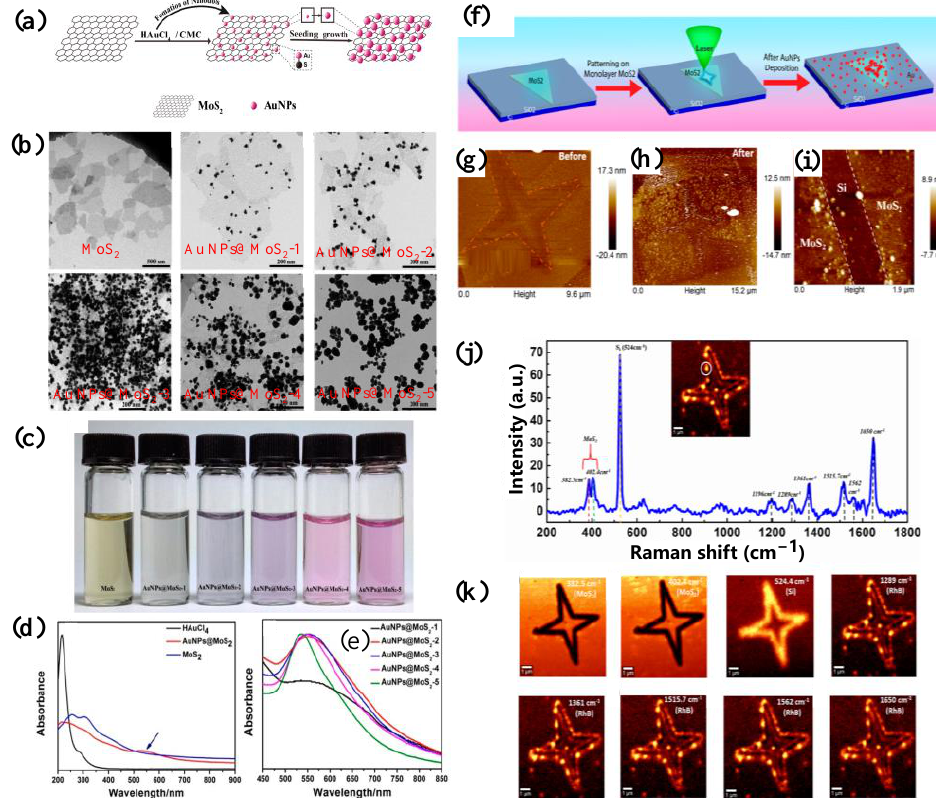
Figure 9. ( a ) Schematic illustration of synthesizing Au NPs@MoS 2 nanocomposite. ( b ) TEM images of MoS 2 and five kinds of Au NPs@MoS 2 nanocomposite with different numbers of Au NPs named from Au NPs@MoS 2 -1 to Au NPs@MoS 2 -5. ( c ) Photo images of MoS 2 nanosheets and different Au NPs@MoS 2 nanocomposite. ( d ) UV − vis spectra of MoS 2 , HAuCl 4 , and Au NPs@MoS 2 nanocompo- permission of 2014 American Chemical Society. ( f ) Schematic graphics demonstrate the nanopatterning of monolayer MoS 2 by laser irradiation, followed by AuNP deposition. ( g , h ) AFM topography image of MoS 2 sheet before and after the decoration of AuNPs on the SiO 2 /Si substrate, showing the distribution of AuNPs on the 2D MoS 2 flake. ( i ) Magnified view of the Au NP decorated the artificial edge of the MoS 2 sheet, where the white dotted lines indicate the outlines of the laser-etched edges. ( j ) Raman peaks of RhB dye (denoted black dotted line) along with characteristic signals of MoS 2 (red and green dotted line) and Si (yellow dotted line), acquired at the edge of the nanostructure (white marked circle in inset panel). ( k ) Raman mapping images of a star-shaped feature at signature peaks of MoS 2 , Si and RhB depicting the formation of localized hotspots along the artificial edges of the star-shaped nanostructure. Reprinted from Ref. [113] with permission of 2020 American Chemical Society.